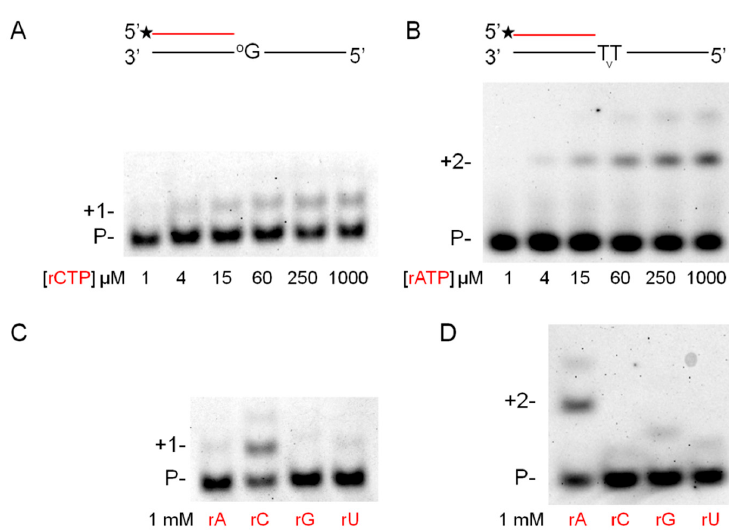
Figure 4. DNA damage bypass by Pol η during RNA synthesis in the presence of manganese. ( A , B ) The template in S12 contained 8-oxoG in the incoming position. Reactions were performed for 3 min with 5-mM Mn 2 + , 1.6-nM Pol η , 8-nM RNA / DNA primer / template and the indicated amount of individual rNTPs. ( C , D ) The template in S16 contained TT dimer in the incoming position. Reactions were performed for 15 min with 5-mM Mn 2 + , 1.6-nM Pol η , 20-nM RNA / DNA primer / template and the indicated amount of individual rNTPs. RNA primers and rNTPs are highlighted in red.